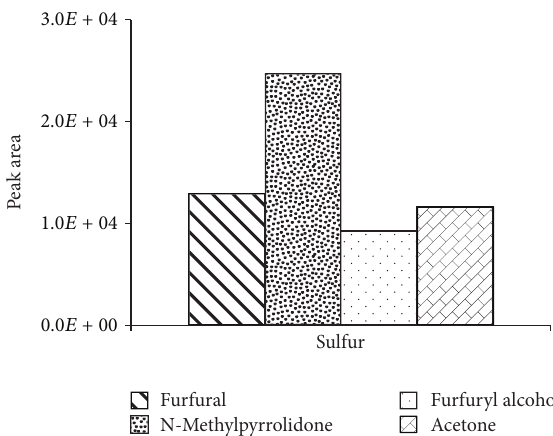
Figure 2: Extraction efficiency of different polar organic solvents used for the SBME-GC-MS